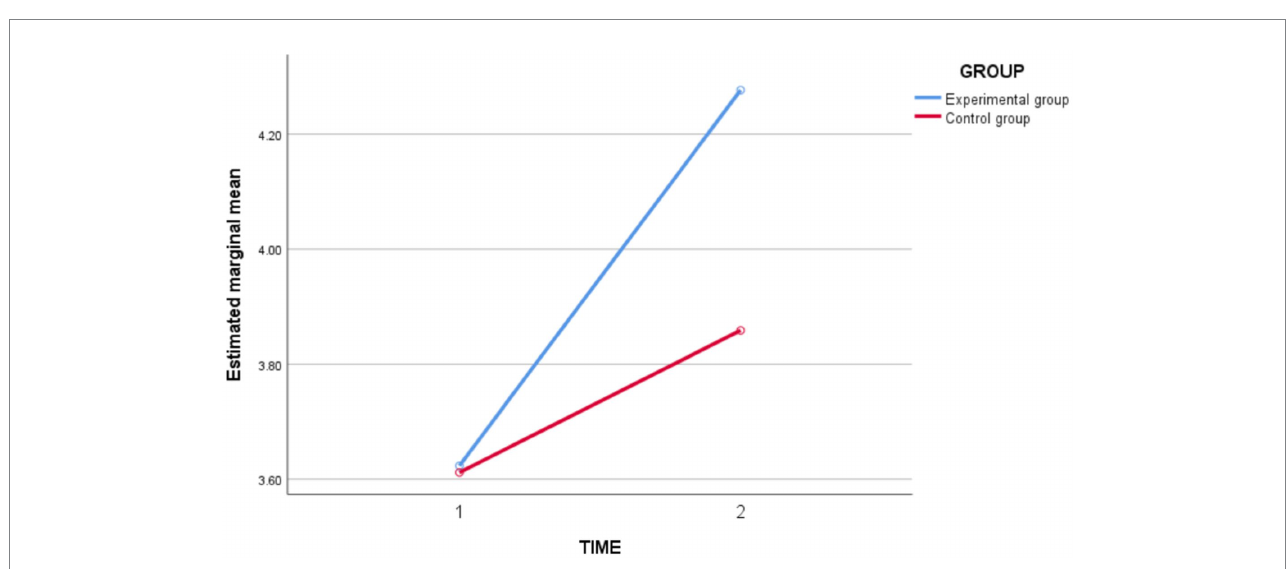
FIGURE 4 Schematic diagram of the changes in cooperation ability between the experimental group and the control group before and after the intervention.